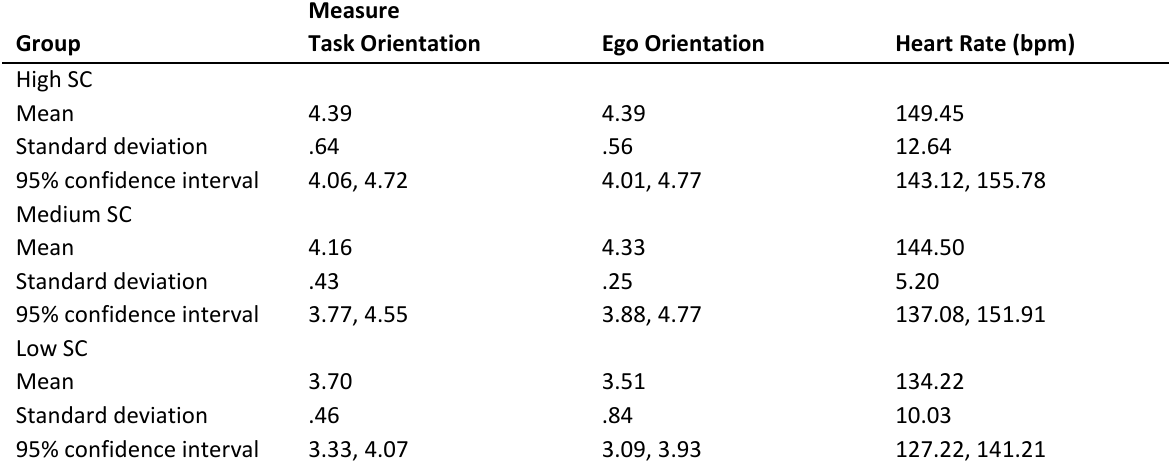
Table 1. Descriptive data by sport confidence (SC) grouping for study